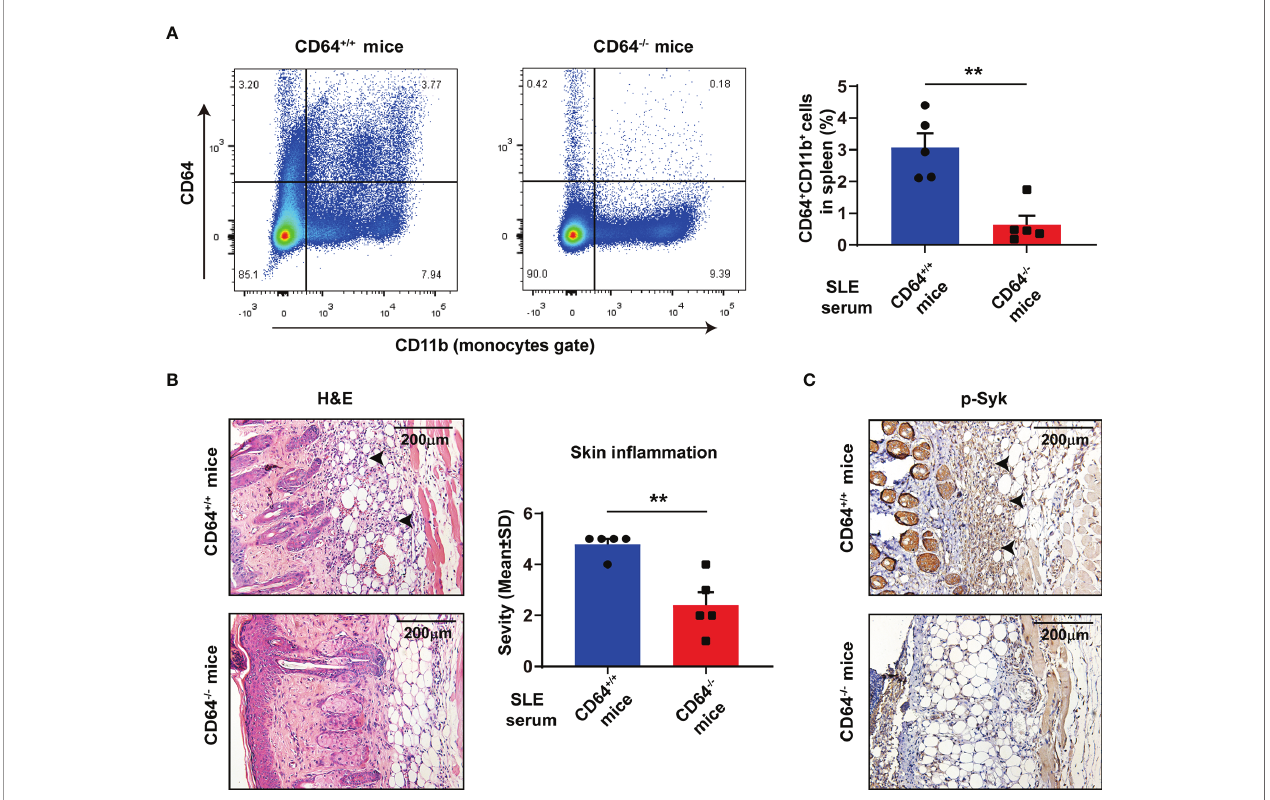
FIGURE 5 | De fi ciency of CD64 in mice alleviated skin in fl ammation induced by SLE serum. (A) Flow cytometry analysis of CD64 and CD11b in splenic cells. n=5 per group. **p < 0.01. (B) Representative histopathology of skin in fl ammation from CD64 de fi cient ( -/- ) mice and wild ( +/+ ) mice with intradermal injection of 100 m L lupus serum. Black arrows refer to in fl ammatory cells. (C) Immunohistochemistry of phosphorylated Syk (p-Syk) in the skins from CD64-de fi cient and wild mice with intradermal injection of lupus serum. Black arrows refer to deposited